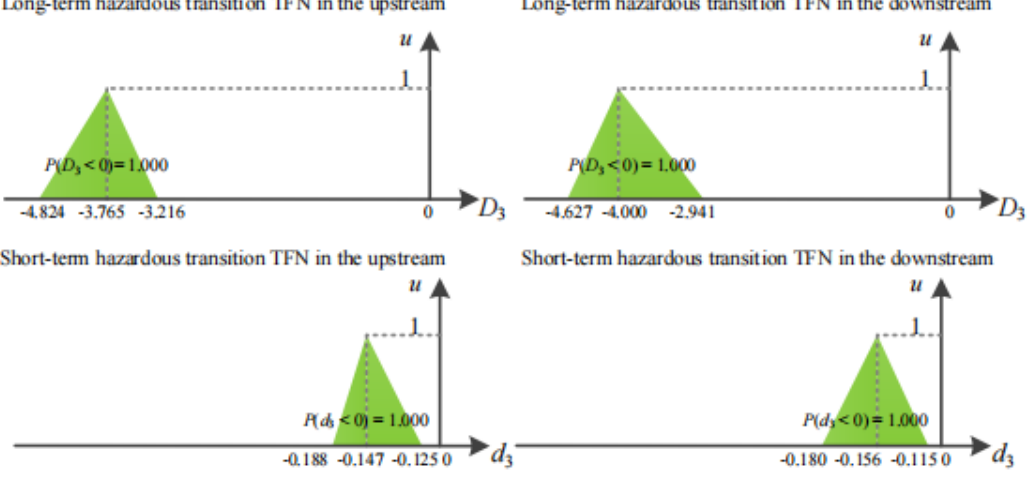
Figure 14. Transition TFN of ecological risk of Pb.